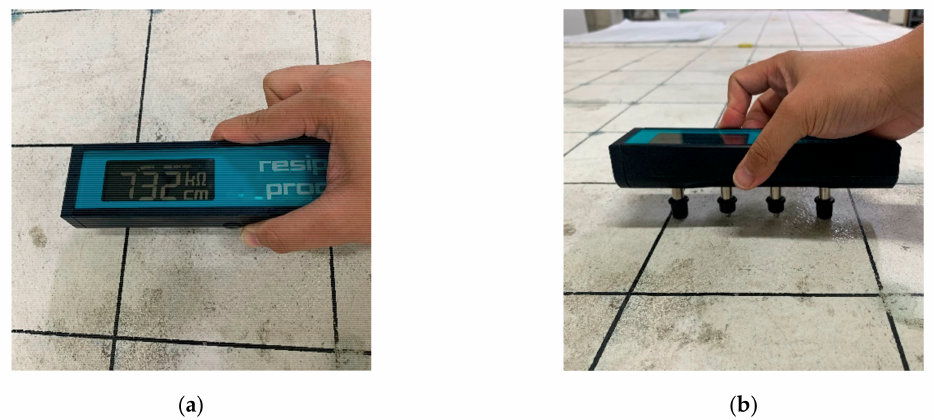
Figure 5. Measurement of ER on a concrete slab surface using a Wenner probe device: ( a ) top view and ( b ) side view of the testing